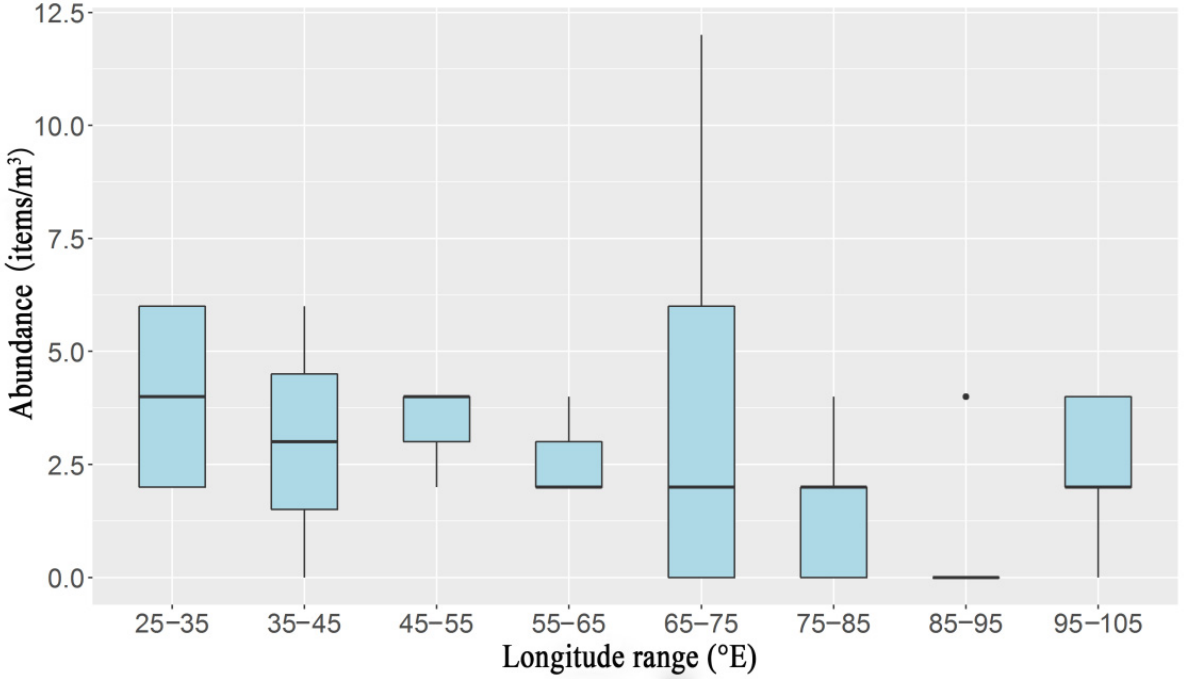
Figure 4. Longitudinal interval abundance of microplastics. Black dot “ · ” is the maximum value of the data